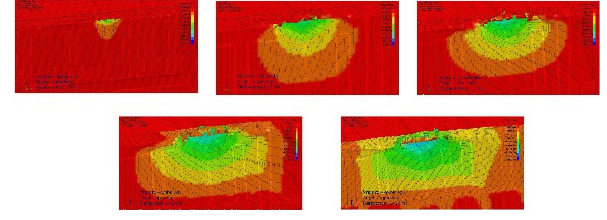
Figure 10: Summary of dynamic displacement behavior of the dou- ble side skin [DSS]